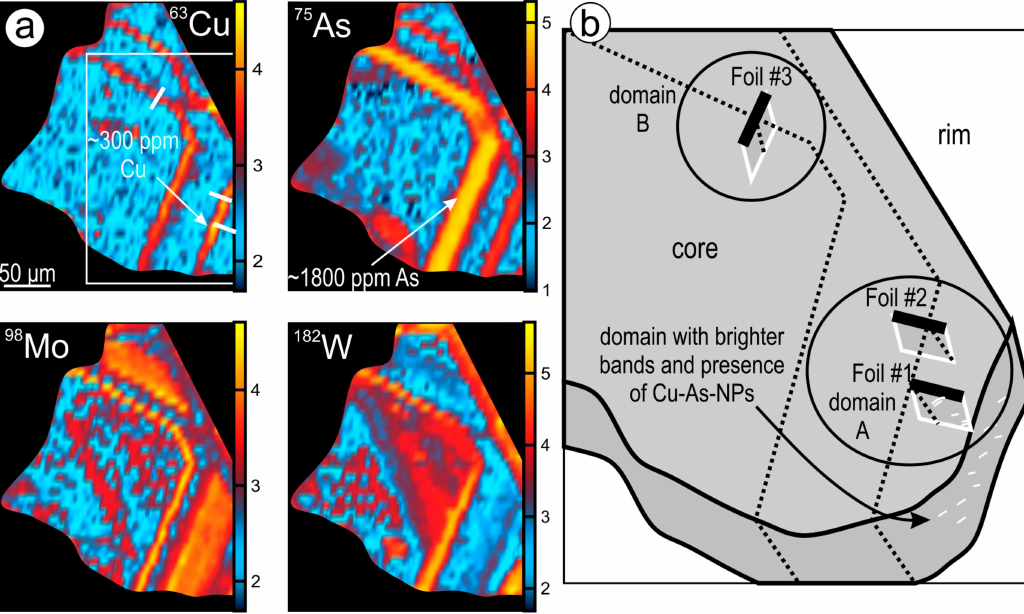
Figure 1. ( a ) LA-ICP-MS element maps of hematite (grain #1) displaying oscillatory zoning with